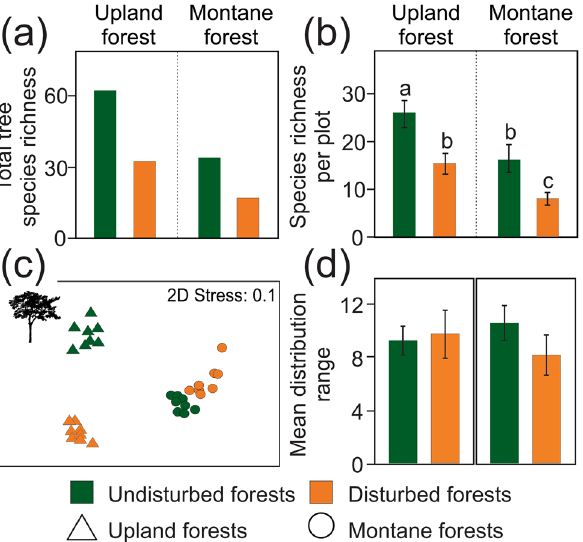
Figure 2. Differences in tree species richness, community composition, and mean distribution range between forests disturbed and undisturbed by elephants. Tree species richness per ( a ) forest site, and ( b ) per sampling plot estimated by GEE (estimated means with 95% unconditional confidence intervals). The letters visualize results of the post-hoc pairwise comparisons. ( c ) NMDS diagrams of the tree community compositions at the sampled forest plots. ( d ) Mean distribution range of trees per sampling plot estimated by GEE.